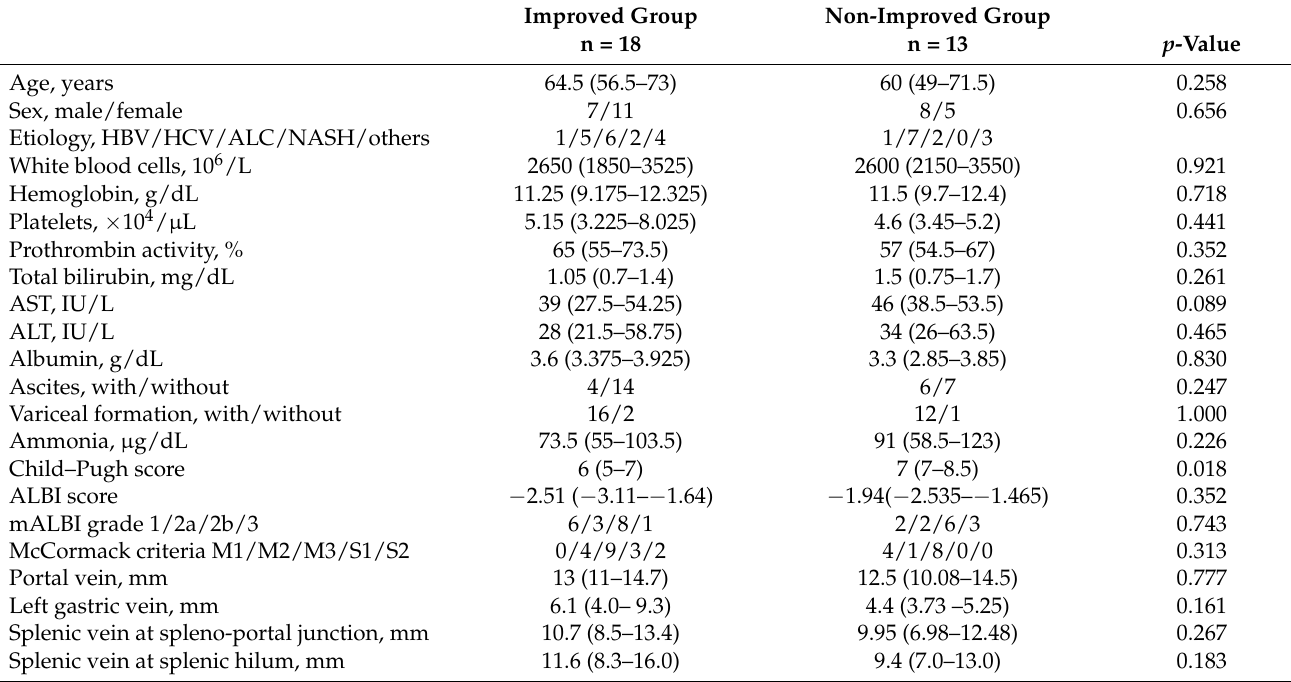
Figure 2. McCormack classification of endoscopy before and after partial spleen embolization. Table 2. A comparison of each variable between the portal hypertensive gastropathy-improved group and the non-improved group .